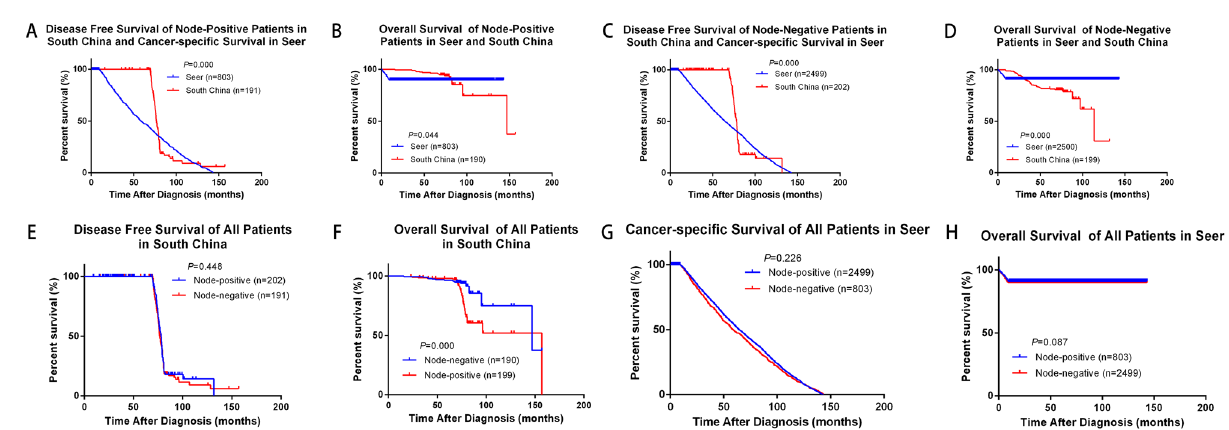
Figure 4. Comparison of different Nodal stage in Southern China and SEER database. ( A , B ) Kaplan–Meier estimates DFS or CSS and OS of Node-positive patients in both Southern China and SEER database, ( C , D ) Kaplan–Meier estimates DFS or CSS and OS of Node-negative patients in both Southern China and SEER database, ( E , F ) Kaplan–Meier estimates DFS and OS of different nodal stage in Southern China, ( G , H ) Kaplan– Meier estimates CSS and OS of different nodal stage in SEER